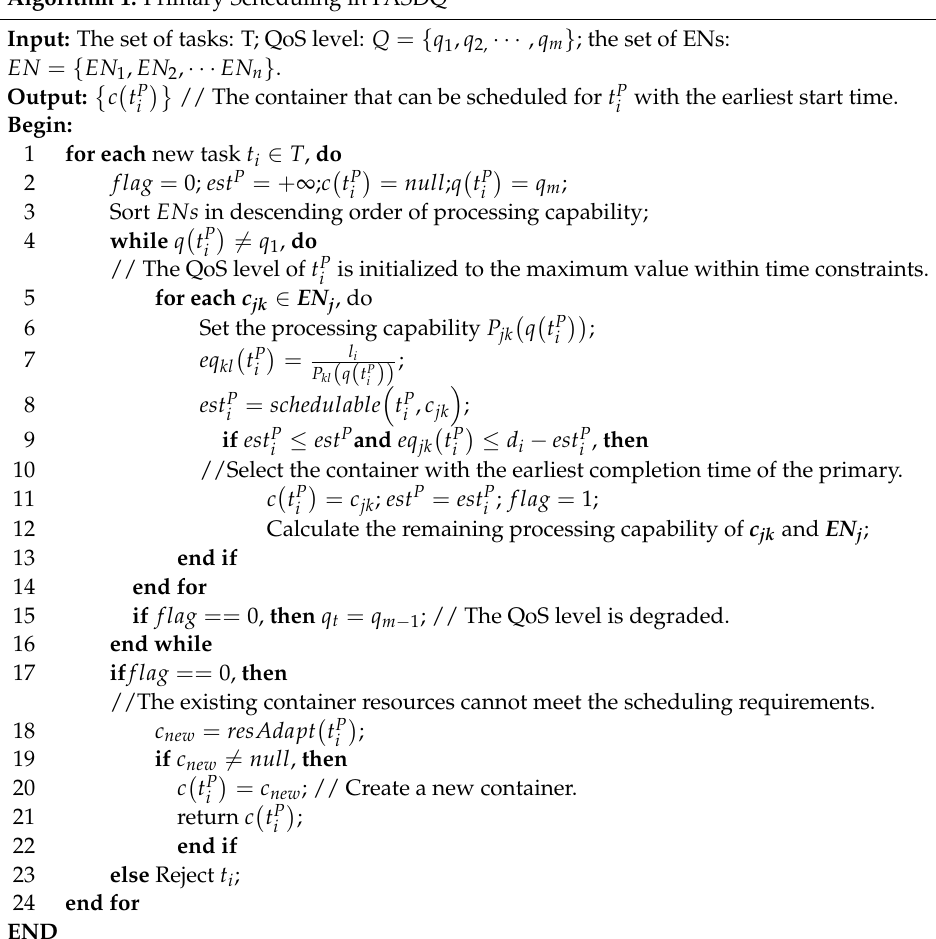
Algorithm 1. Primary Scheduling in FASDQ